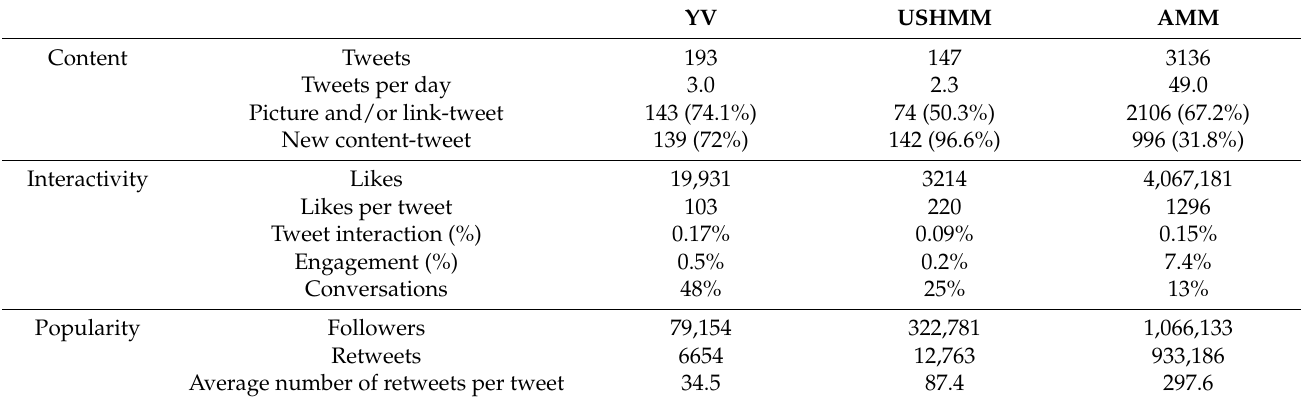
Table 3. Content, interactivity, and popularity of museums’ Twitter profiles.